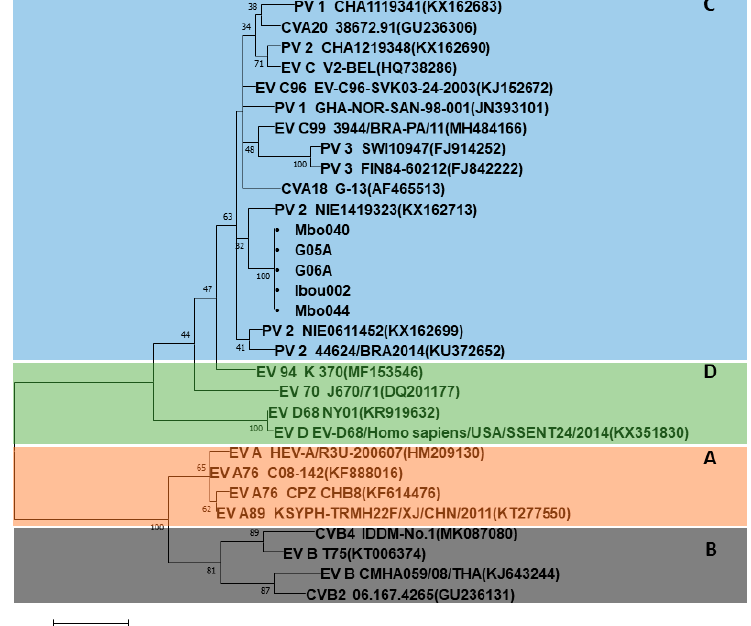
Figure 3. Phylogenetic tree based on the 5’-UTR partial sequences of the human enterovirus serotypes A–D (indicated by colors and letters A–D) and the enterovirus (EV) isolates in the present study (indicated by black circles at the beginning). Isolates form gorillas or from humans, highlighted with black circles, are identical in each other and they clustered with poliovirus (PV)2 (KX162714) of the EV-C.